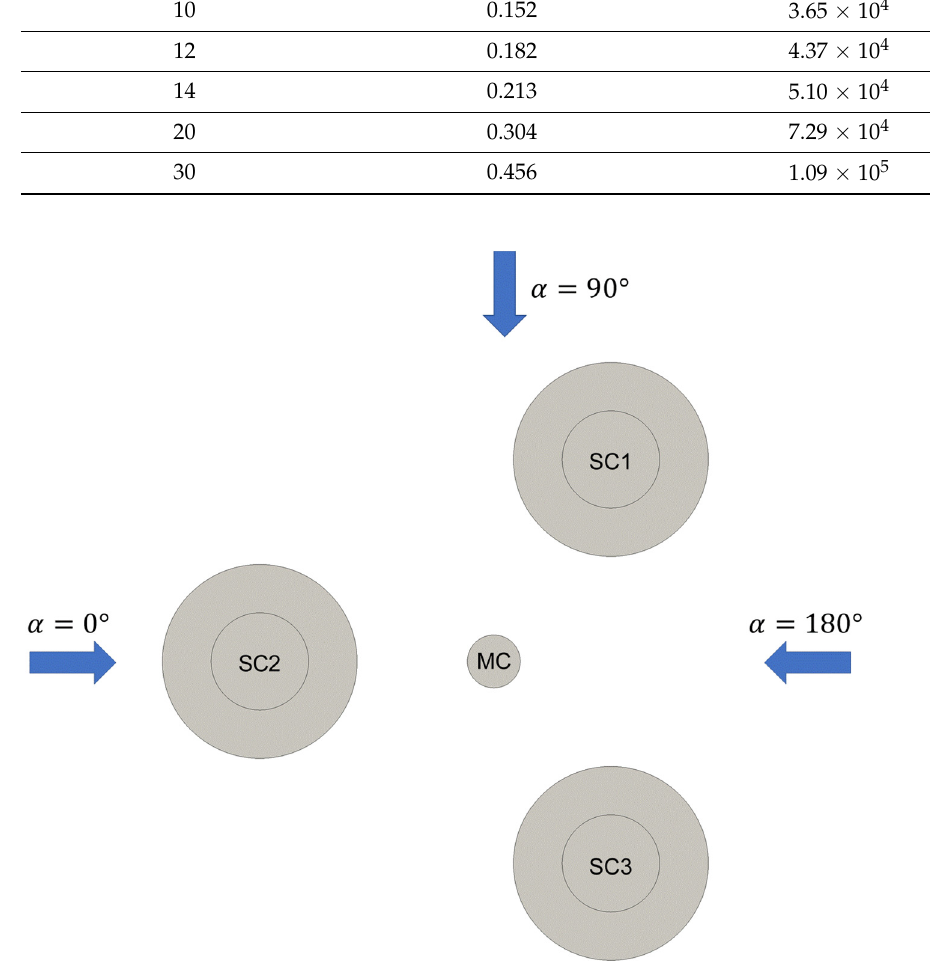
Figure 2. Definition of current incidence for FOWT platform.